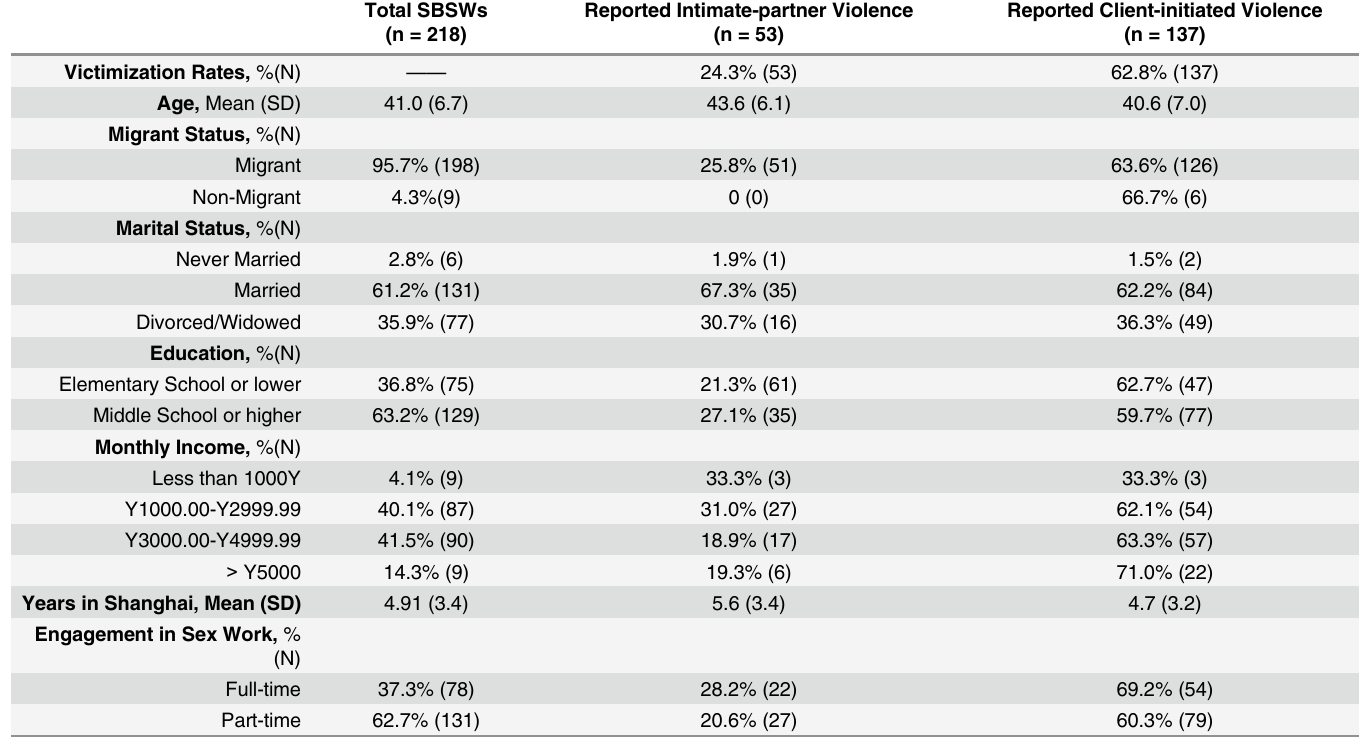
All p-values were greater than 0.05 using chi-square, ANOVA (means), and Fisher Exact test when comparing socio-demographic characteristics between those who reported IPV vs. no IPV, and CIV vs. no